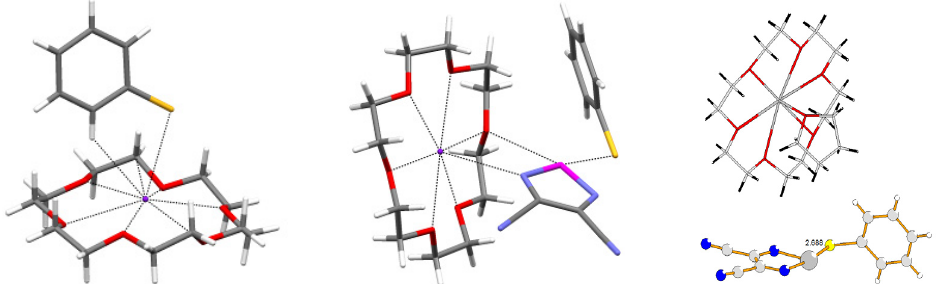
Figure 10. XRD structures of reaction products from thiophenolate and compounds 73 (middle) and 35 (right; solvate with THF) in comparison with that of [K(18-crown-6)] + [PhS] −